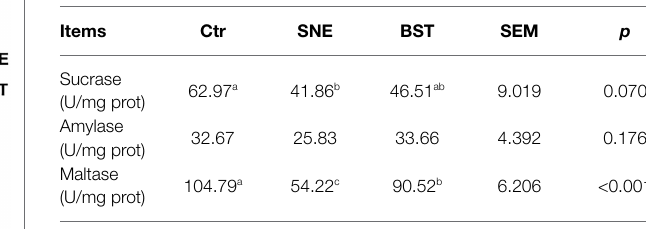
a,b,c Mean values with unlike letters between different groups were significantly different (p < 0.05). Ctr group, basal diet in control group; SNE group, basal diet + SNE (20-fold dose coccidiosis vaccine) + 1 ml of Clostridium perfringens (2 × 10 8 cfu/ml coinfection); BST